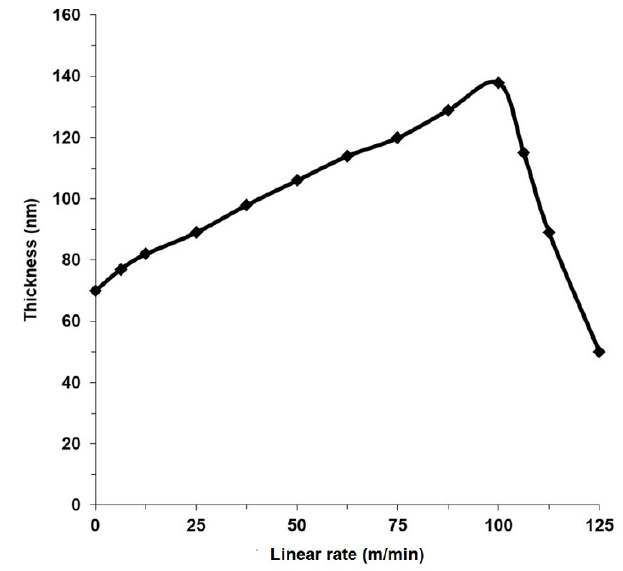
Figure 6. The dependence of the coating thickness on the linear rate of the solution flow along the treated surface.